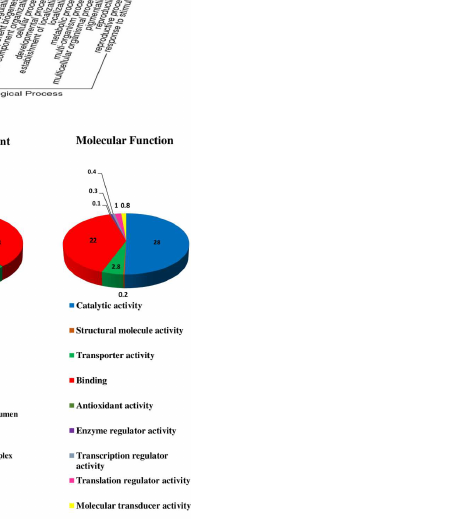
Fig 3. Assignment of Gene ontology (GO) term for predicted genes of T . indica genome into three categories: cellular component, molecular function and biological process.